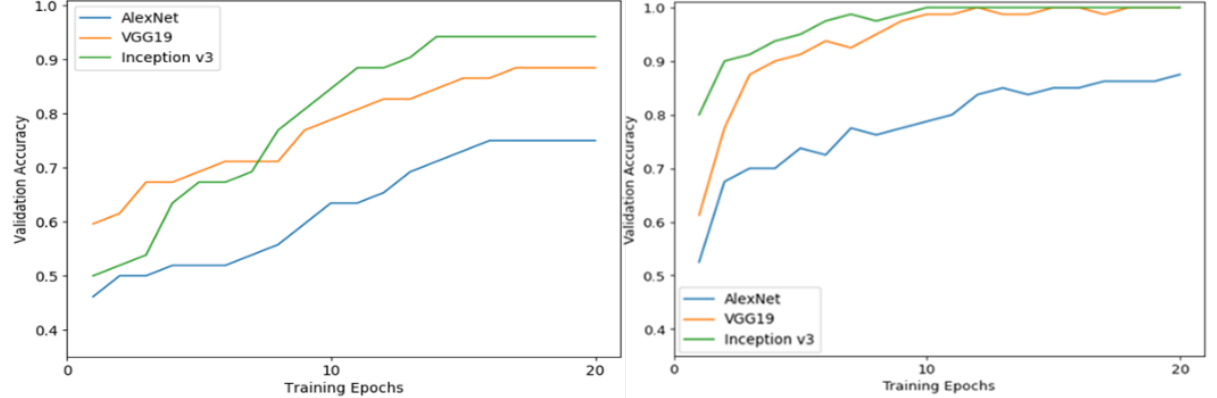
Figure 6. Validation accuracy in the different training epochs for the three different proposed deep learning pretrained models. The figure on the left side shows the results for models created using the feature extraction strategy and the figure on the right shows the results for models created using the fine-tuning strategy, on the PlantVillage